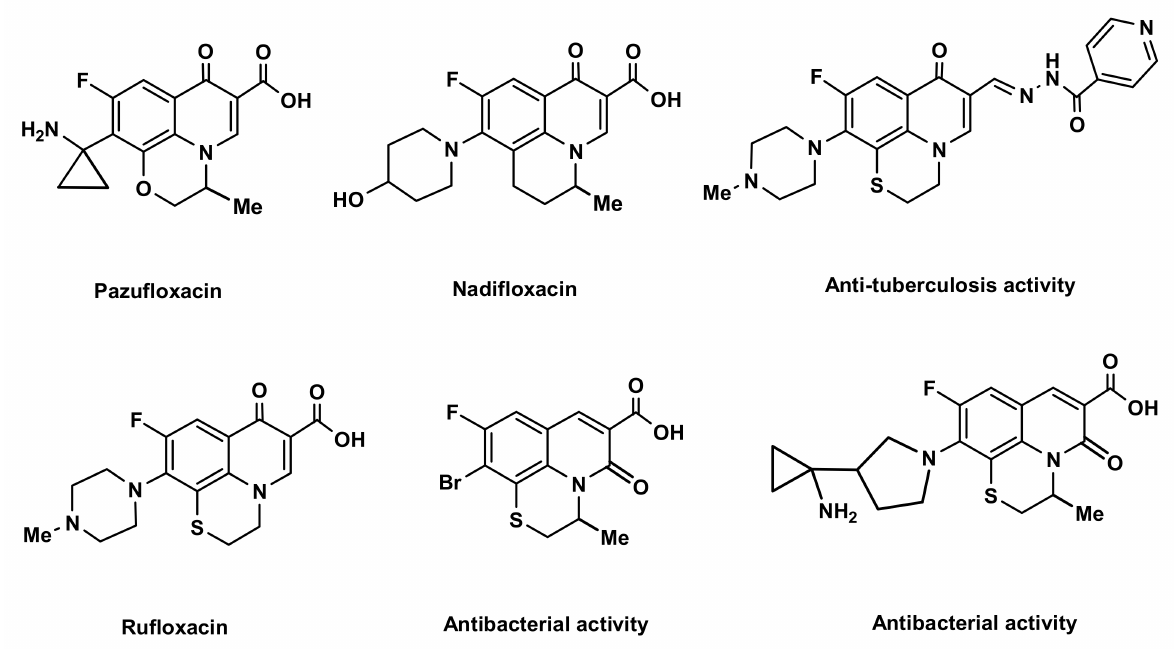
Figure 1. Known biologically active compounds structurally related to the 2 H ,3 H -[1,4]thiazino[2,3,4- ij ]quinolin-4-ium scaf- fold, which have the quinoline ring condensed with six-membered cycles (fluoroquinolone antibiotics [17–19], compounds with antibacterial [22] and anti-tuberculosis [23]